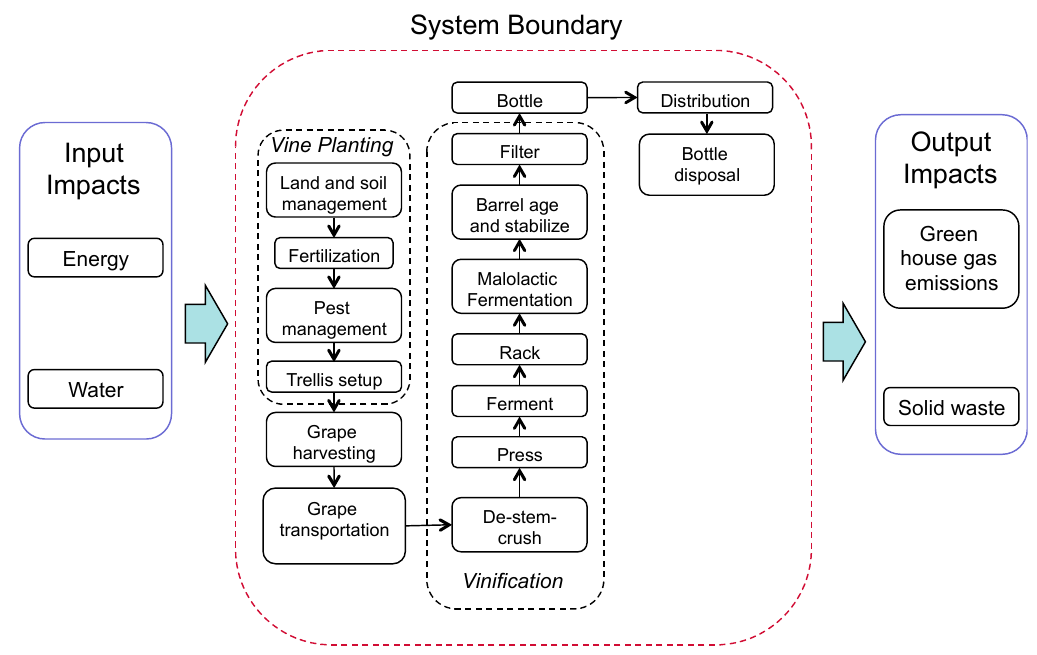
Figure 1. System boundary, inputs, and outputs used for life-cycle assessment (LCA) and techno-economic analysis (TEA) in this study. Table 1. Data inventory for energy and water consumption for various stages of wine making per functional unit * . Vine Planting Wine Making Bottle Manufacture